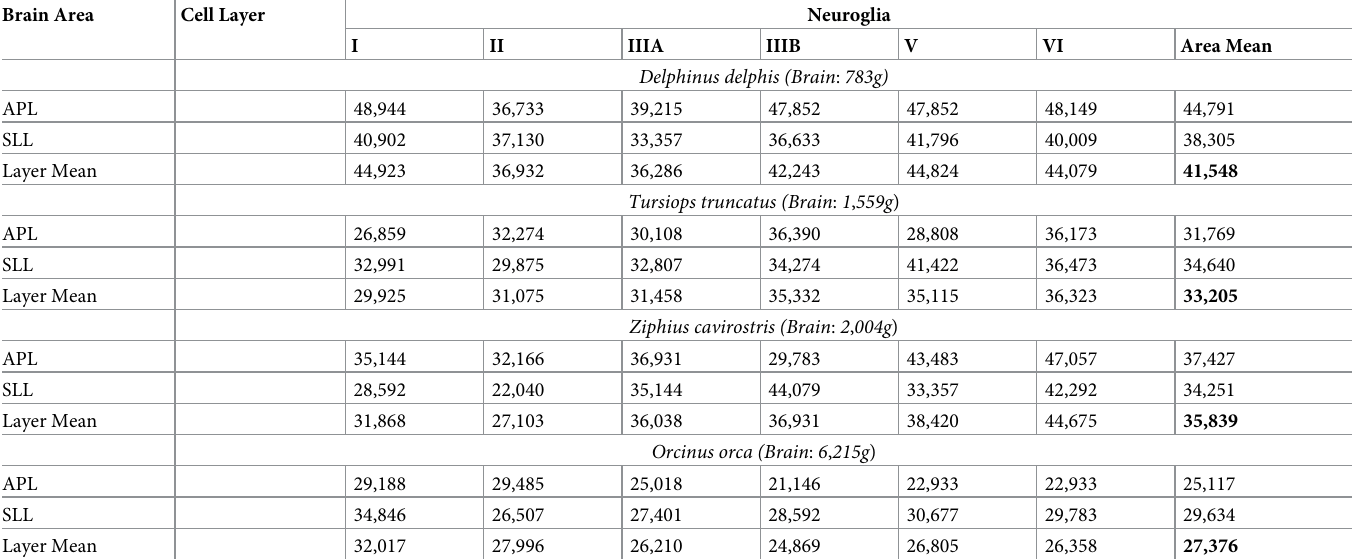
Table 3. Glia density by cortex layer.